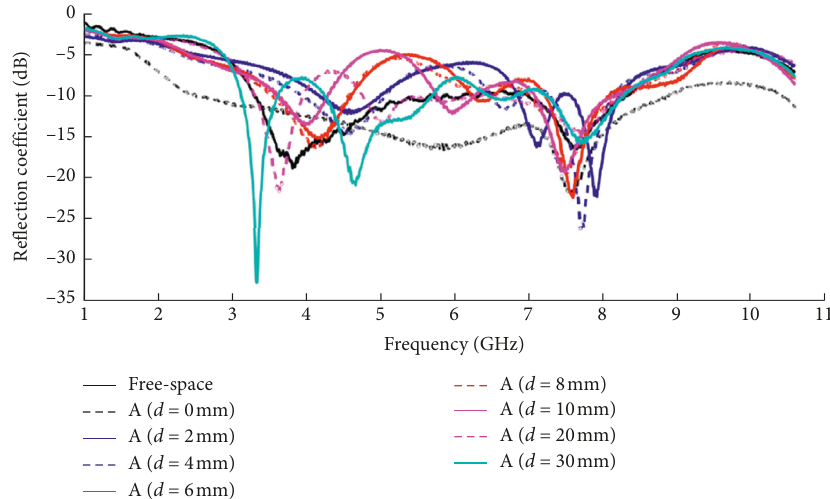
Figure 22: Measured on-body reflection coefficient of the reflector-backed antenna for several distances d .